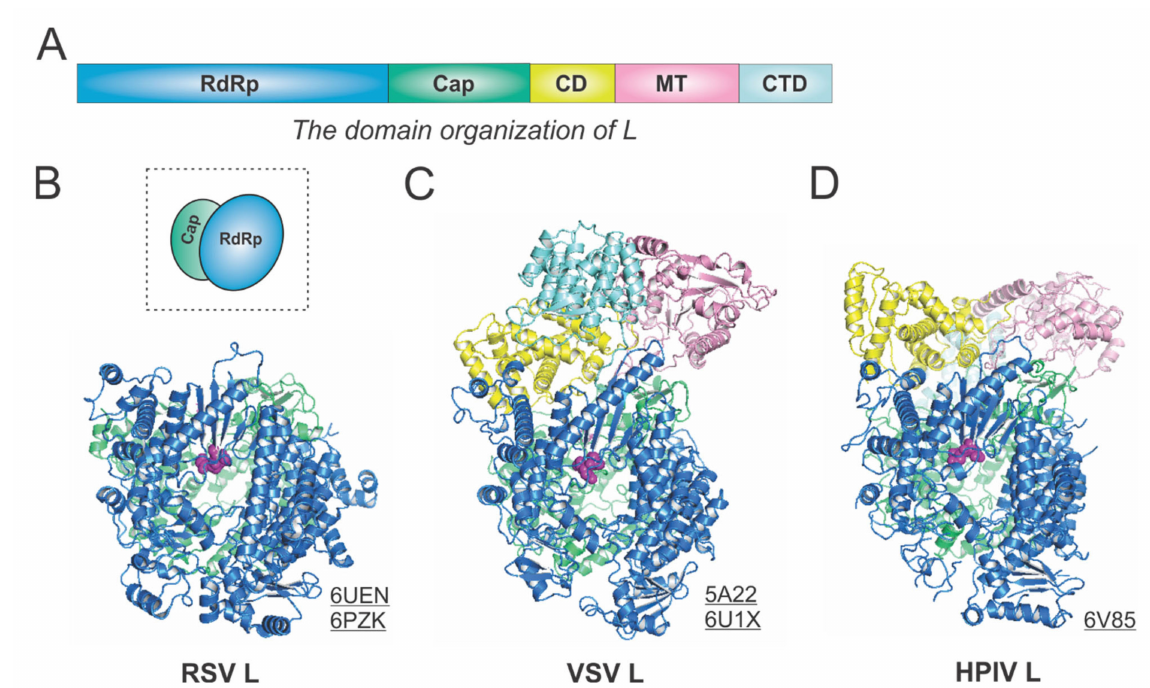
Figure 3. The structures of the L protein from RSV and other representative viruses. ( A ) The linear domain organization of the L protein. There are five domains, namely, the RNA-dependent RNA polymerization (RdRp, blue), the cap addition (Cap, green), the connector domain (CD, yellow), the cap methylation domain (MT, pink), and the C-terminal domain (CTD, cyan). ( B ) The model of the RSV L is extracted from the structures of the RSV polymerase (PDBs: 6UEN and 6PZK). The cartoon representation of the RSV L is shown in the dotted box. ( C ) The model of the VSV L is extracted from the structures of the VSV polymerase (PDBs: 5A22 and 6U1X). ( D ) The model of the HPIV L is extracted from the structure of the HPIV polymerase (PDB: 6V85). The PDB accession codes are